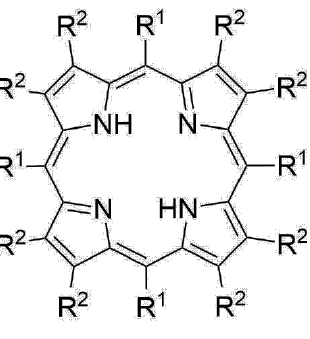
Figure 1. The dodecasubstituted porphyrins 2,3,7,8,12,13,17,18-octaethyl-5,10,15,20-tetraphenylporphyrin (H 2 OETPP, H 2 1 , R 1 = Ph, R 2 = Et) and 2,3,7,8,12,13,17,18-octaisobutyl-5,10,15,20-tetraphenylporphyrin (H 2 OiBuTPP, H 2 2 , R 1 = Ph, R 2 = iBu) discussed in this article.